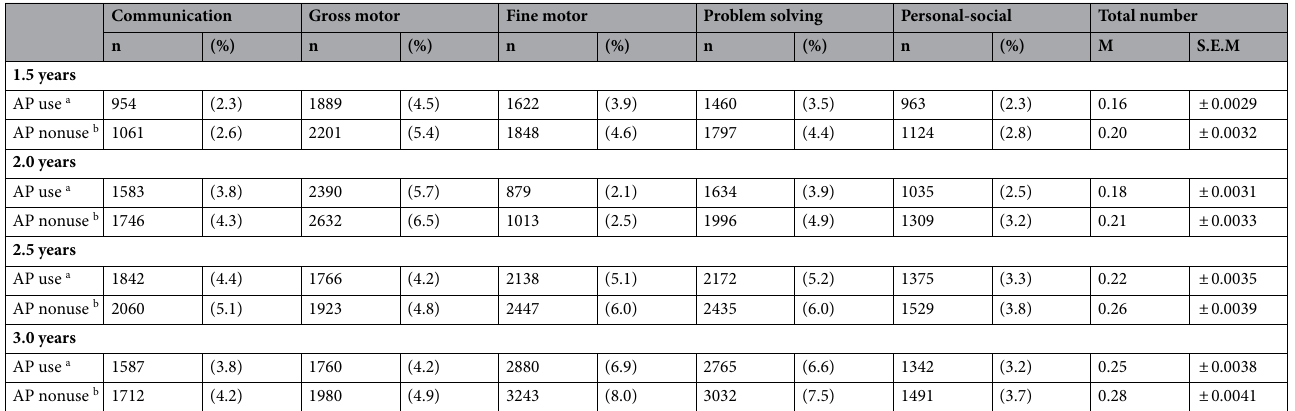
Table 2. Cases and prevalence of developmental delay at four time points in various areas of the ASQ-3 and the total number of cases according to use or nonuse of air purifiers. a n = 41,951. b n = 40,506. Based on imputed data for the 82,457 mother-toddler pairs in this study. ASQ-3 = the Ages and Stages Questionnaire, Third Edition, AP = air